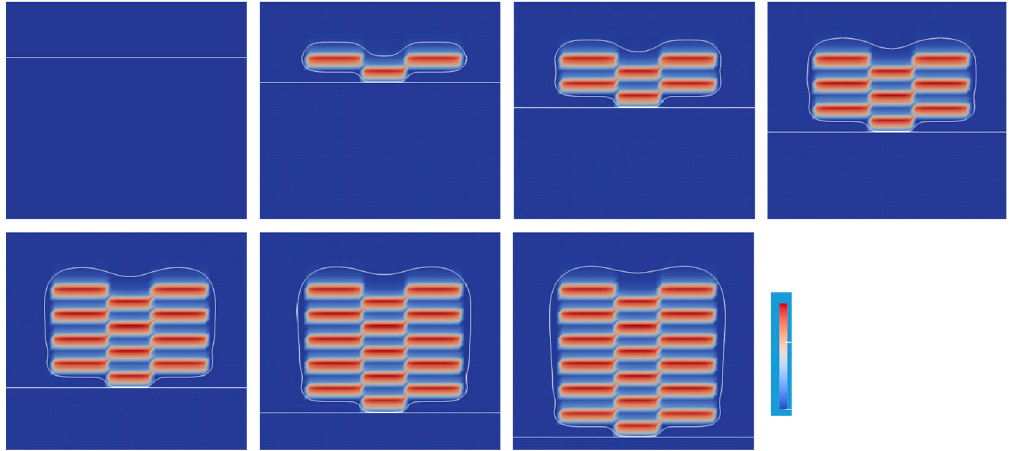
Figure 9. Change of oxygen and C = C bond conversion at the lift-up speed of 1 mm / s. The corresponding video is Video S2 on the website of the Supplementary Materials.